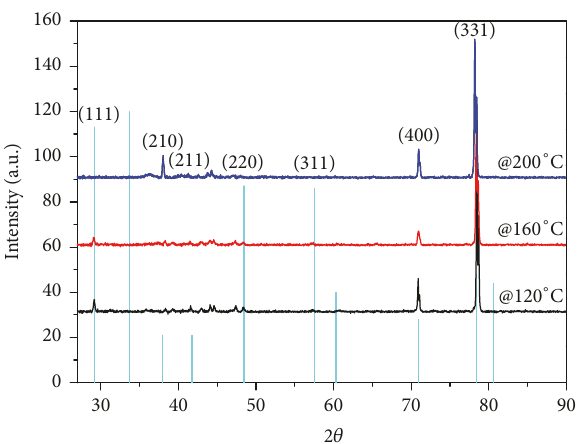
Figure 3: X-ray diffraction pattern of HDA-capped CdO nanoparticles synthesized at 120, 160, and 200 ∘ C.